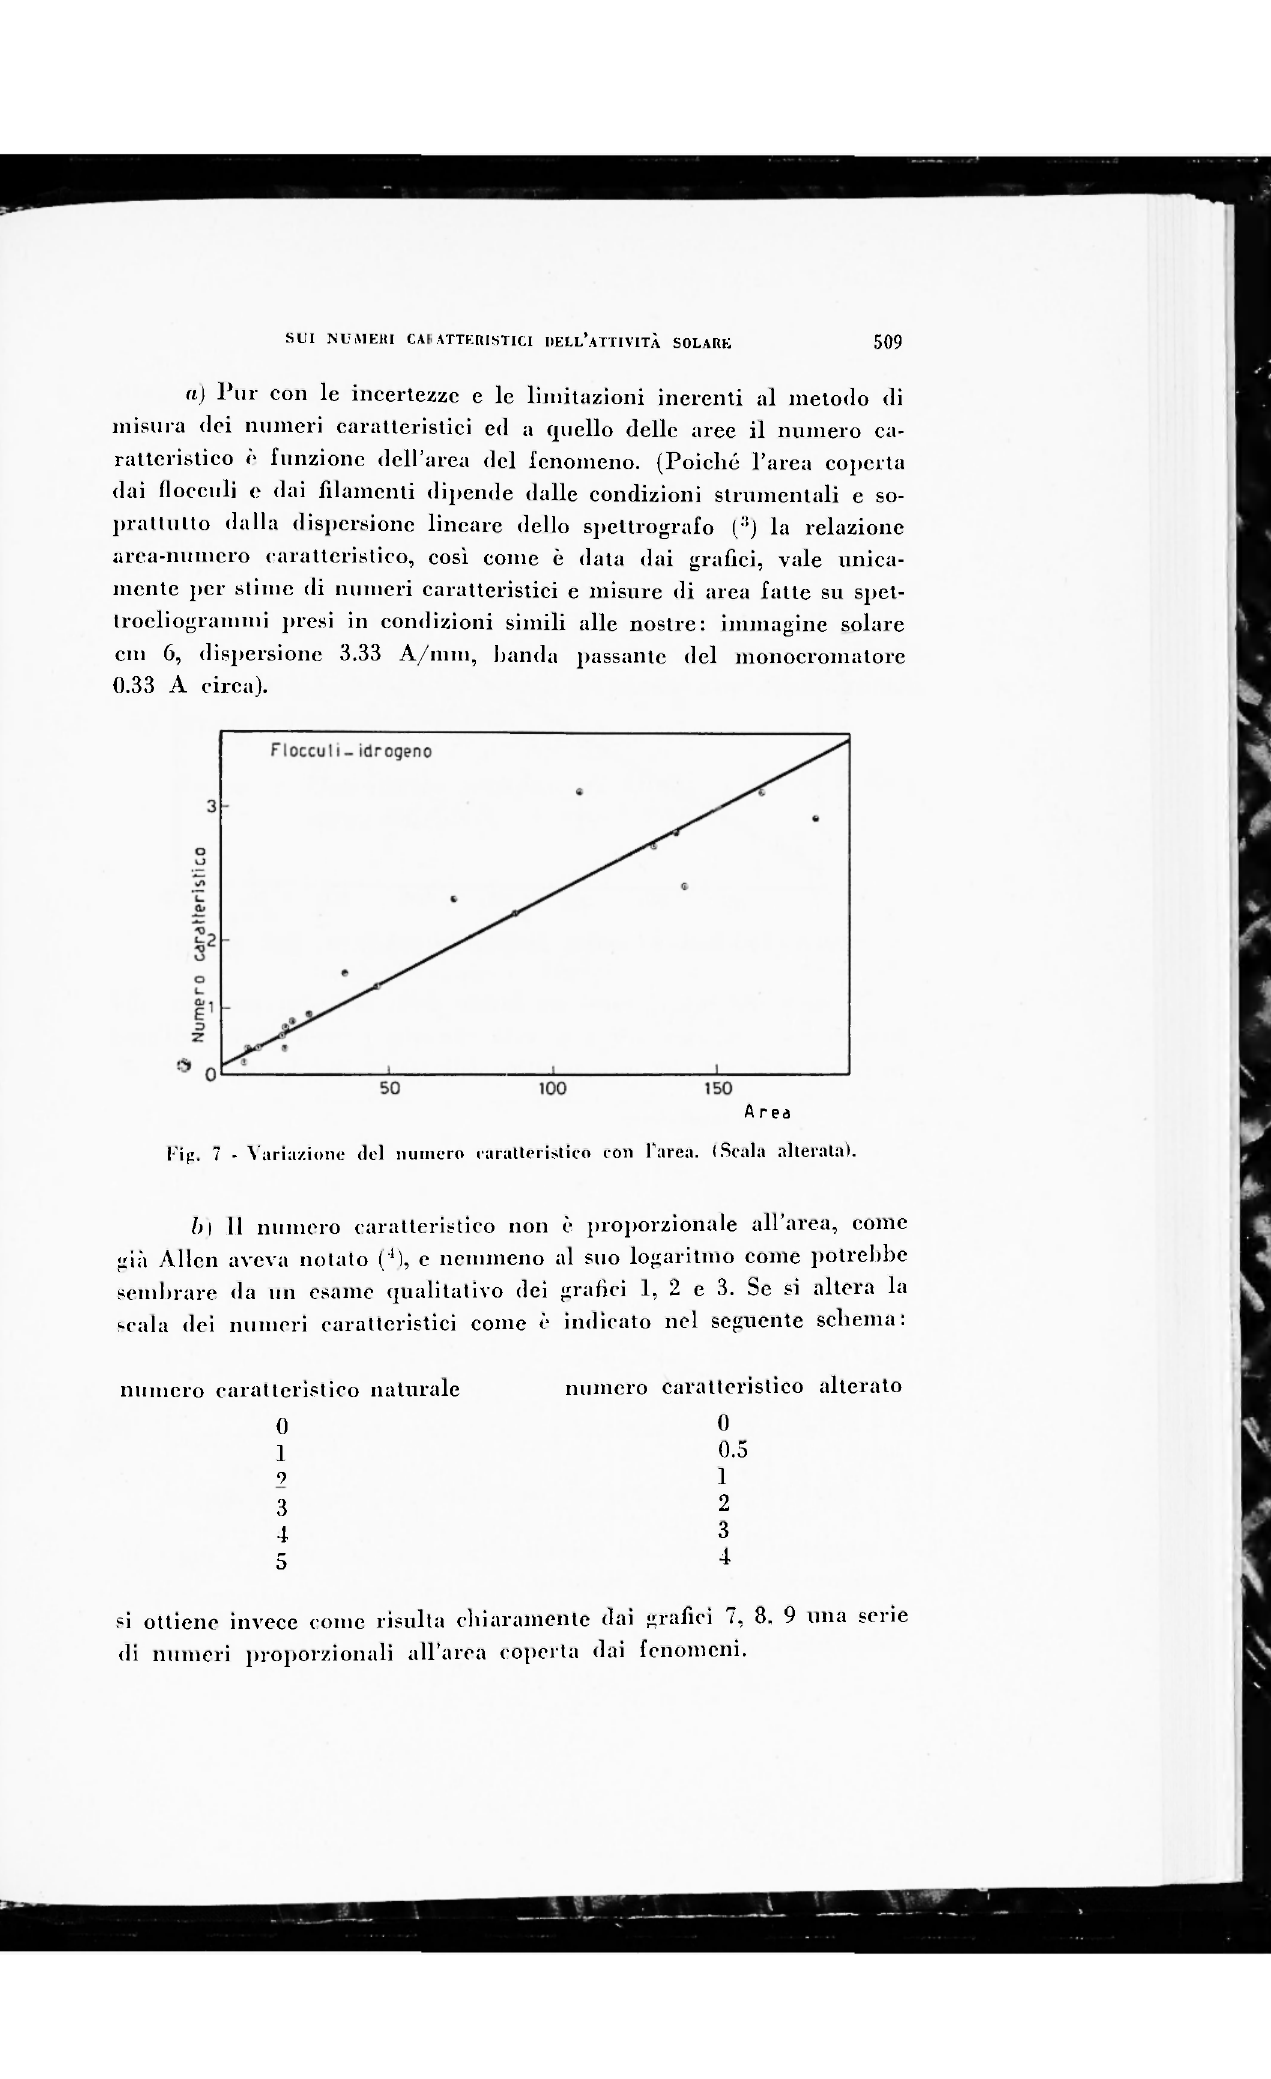
l)ì II numero caratteristico non è proporzionale all'area,